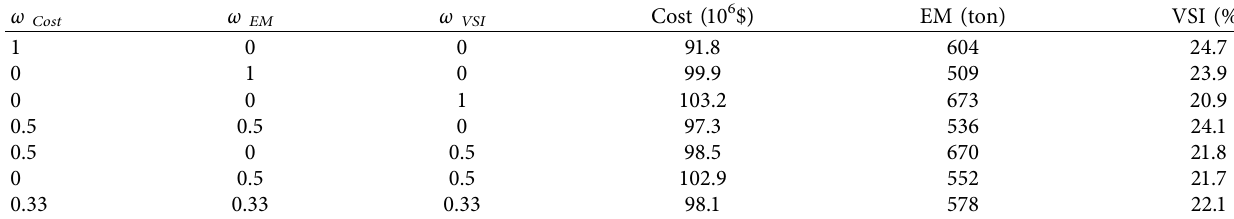
Table 2: Pareto front of the suggested deterministic GTEP